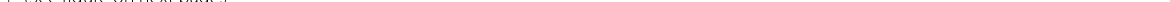
2(See figure on next Fig. 10 a Horizontal (at 3, 5, and 7 km depths) and b vertical slices at the Y-axis (at 2, 10, 20, 30, 40, and 50 km distances from the southern edge of the map) of the Cagayan Valley Basin’s (CV) 3-D density contrast model. The c horizontal and d vertical slices at the Y-axis of the 3-D density contrast model of the Central Luzon Basin (CL) present broader and deeper, and negative density contrast zones. Coordinates ( a , c ) are in WGS 84/ UTM Zone51 N (km). The comparison of the geological cross sections (upper) and density contrast model ( 1.5 vertical exaggeration) resulting × from the 3-D inversion (lower) are presented for the e CV and f CL. KPG Cretaceous–Paleogene, LM Lower Neogene, UN Upper Neogene, = = = OLM Oligocene–Lower Miocene, MM Middle Miocene, UM Upper Miocene, PP Plio–Pleistocene. The geological cross sections are modified = = = = from Tamesis (1981), and the locations of the maps and section lines are shown in Fig.